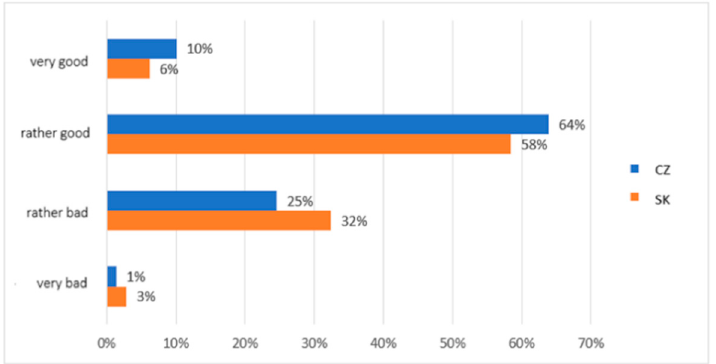
Figure 7. Descriptive statistics of the participants’ subjective perception of social and pastoral service quality (comparison of the healthy population of eastern Slovakia and north-western Czech Republic). Legend: CZ—healthy population of north-western Czech Republic, SK—healthy population of eastern Slovakia. Source: own resource.